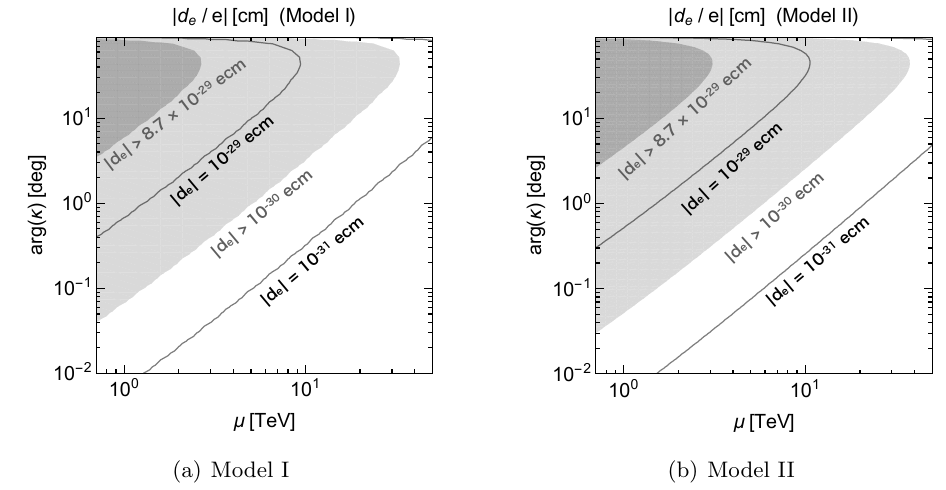
= (cid:22) = (cid:22) +100 GeV, (cid:22) (cid:22) = (cid:22) +50 GeV, Q L u